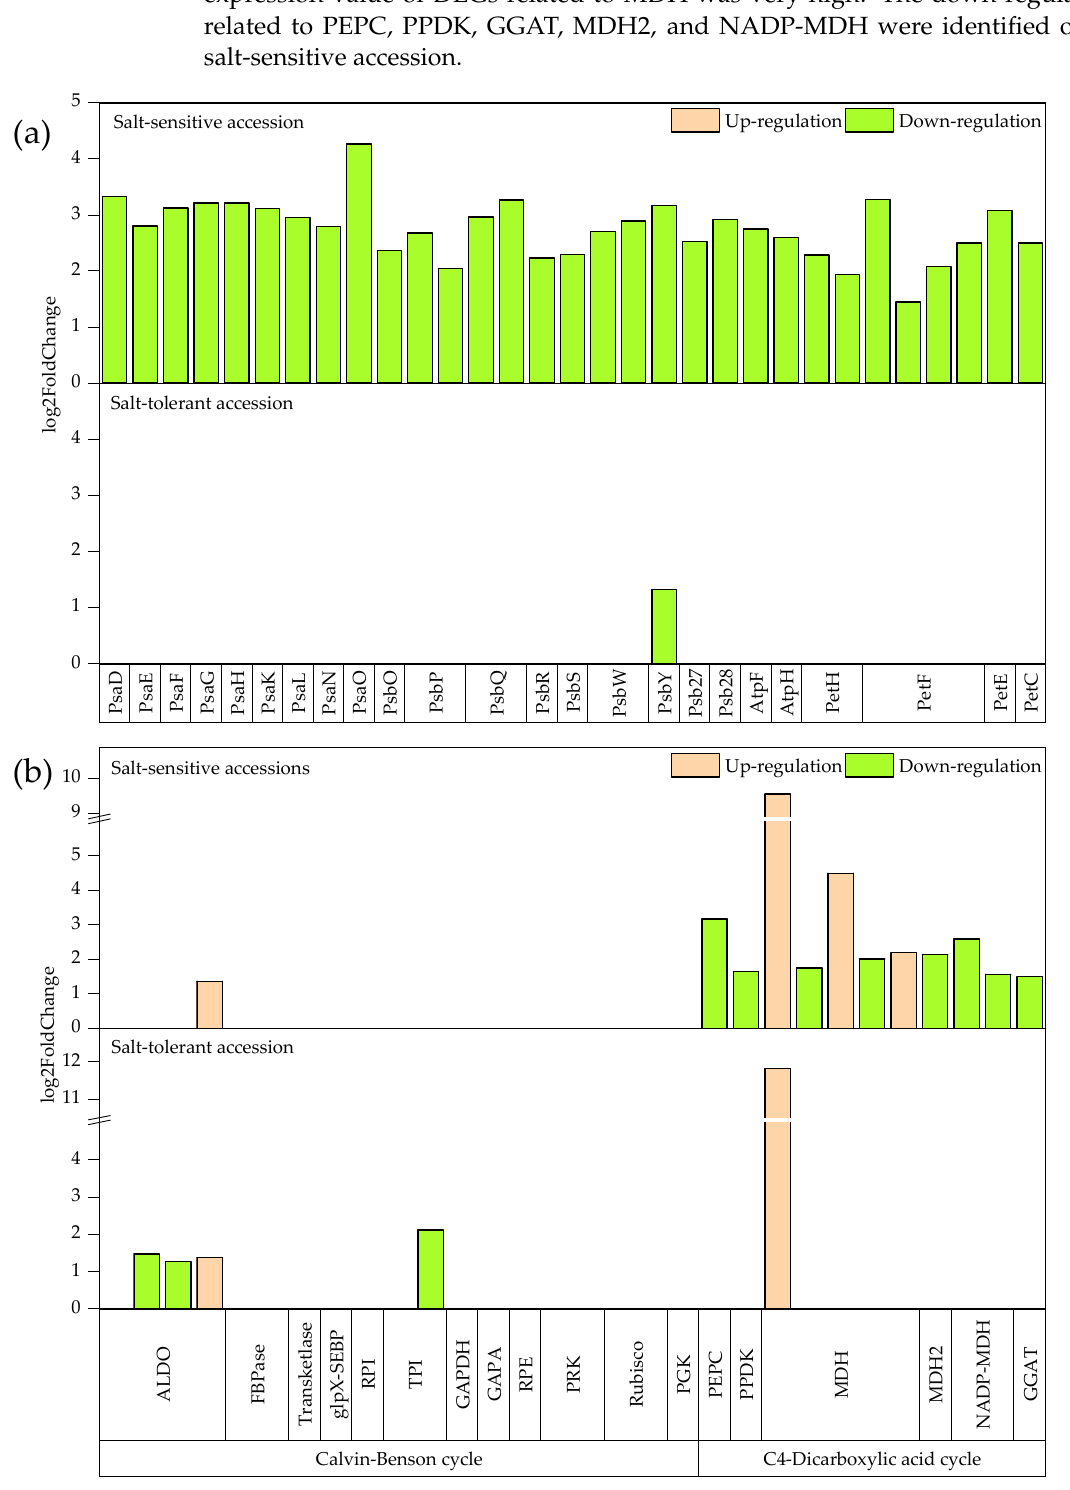
Figure 3. Differentially expressed genes in photosynthesis pathway (sita00195) ( a ) and carbon fixation in photosynthetic pathway (sita00710) ( b ) in salt-sensitive and salt-tolerant accessions. The green and red colors represent down- and up-regulated genes, respectively.